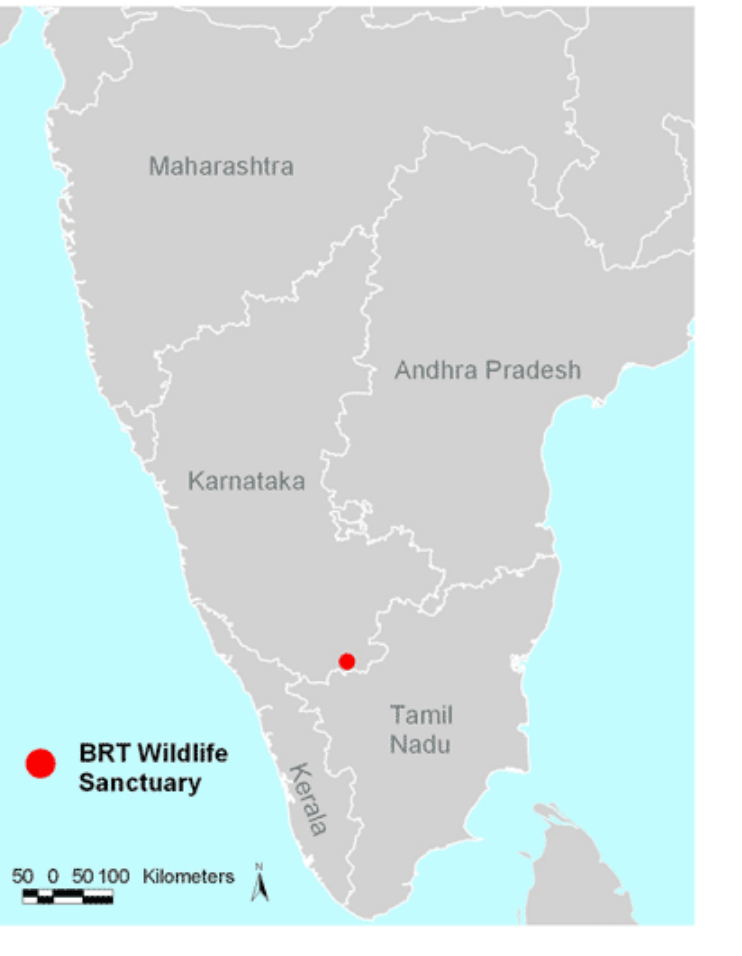
Fig. 1. The Biligiri Rangaswamy Temple (BRT) Wildlife Sanctuary in Karnataka, India. Map provided by